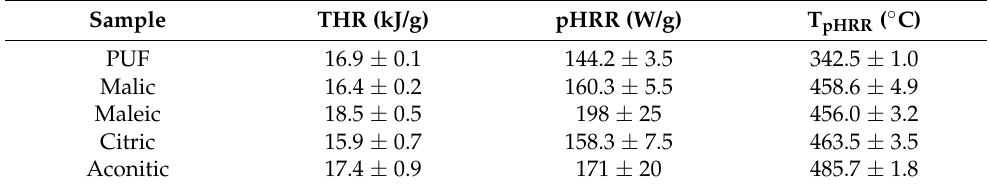
Figure 5. Representative microscale combustion calorimetry results for each foam sample. Table 2. Microscale combustion calorimetry parameters for each foam sample.